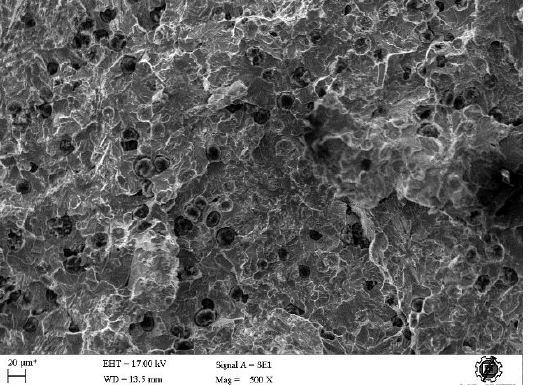
Figure 35. Fractured surface of